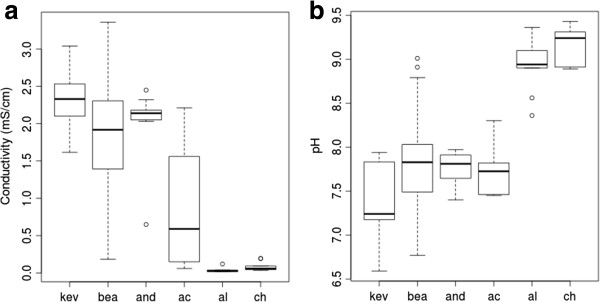
Geochemical features of sampling locations (n = 68). (a) Boxplots for conductivity and (b) boxplots for pH.